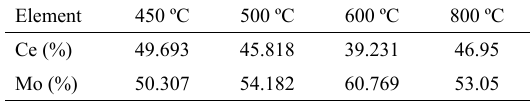
Table 2. Atomic percentages of Ce and Mo by EDS analysis of cerium molybdate samples calcined in the temperature range 450ºC - 800ºC.